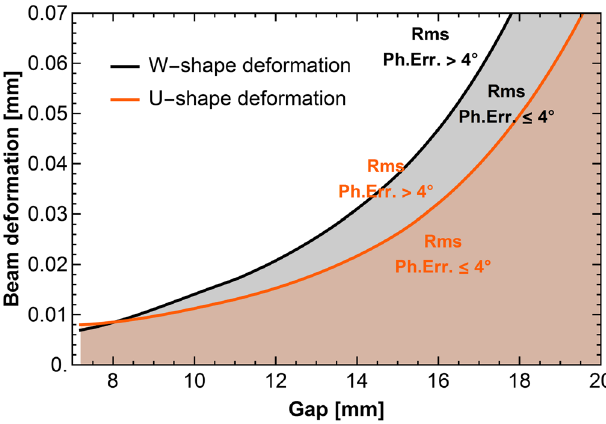
FIG. 7. The strongback deformation (peak to peak) that results in an rms phase error matching the 4° requirement is shown as a function of gap for two different shapes of deformation. At the minimum gap of 7.2 mm, a deformation that exceeds 7 or 8 μ m (depending on deformation shape) will result in excessive rms phase error. The deformation can be allowed to be larger at larger gaps. Note that this only includes mechanical shape. On a real undulator, magnetic tuning (see below) will further improve the rms phase error, but the mechanical shape must reproduce to this